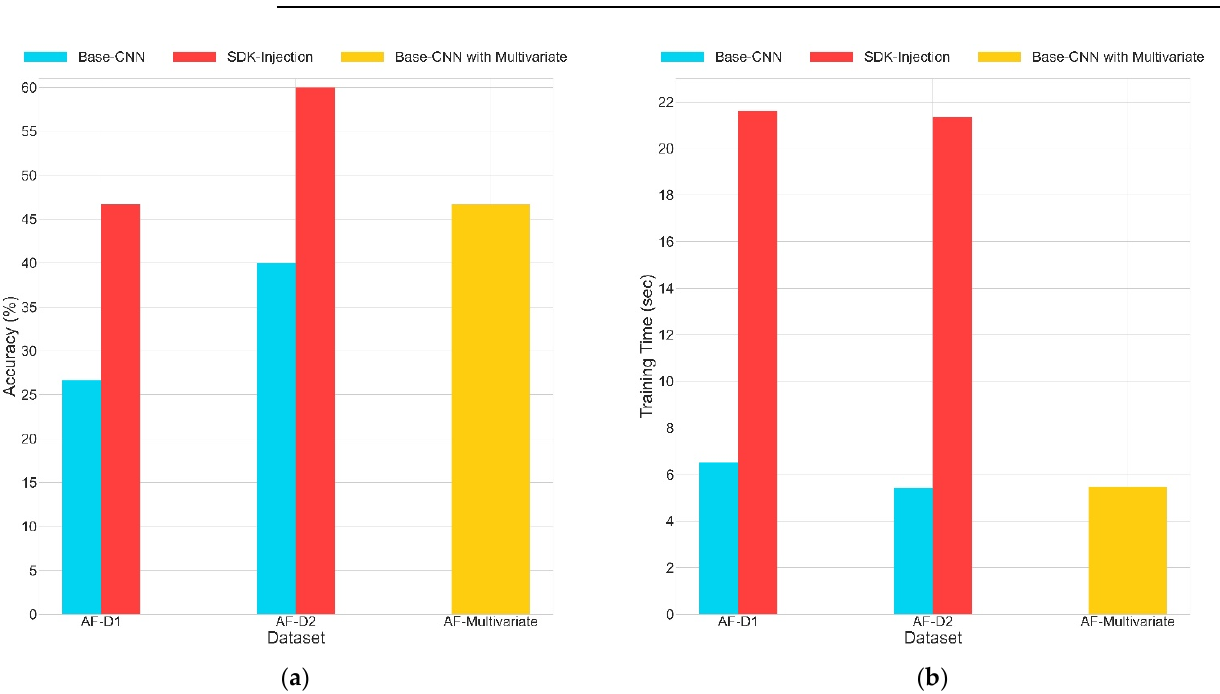
Figure 7. Dual-variate ECG analysis with Base-CNN using dataset AF-D1 and AF-D2 for the diagnosis of atrial fibrillation.